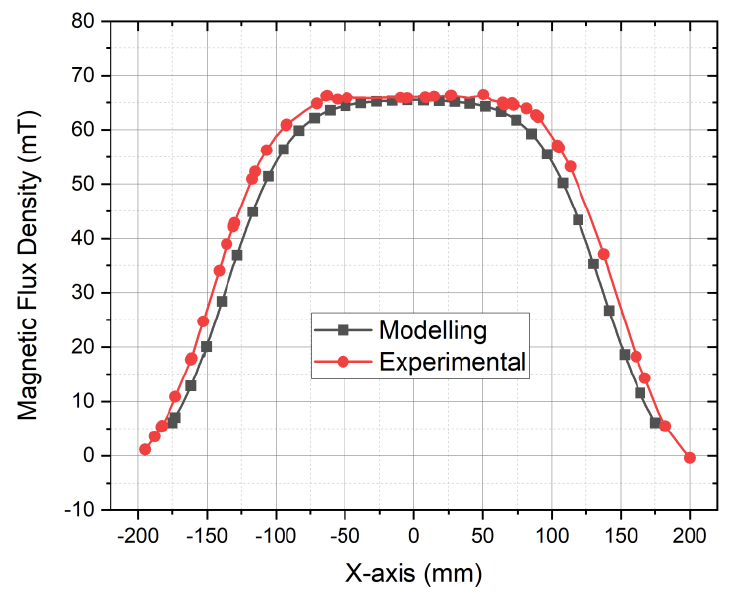
Figure 6. Experimental and modelling magnetic field of the magnet with the magnetic field ( B z ) 60 mm above the magnet.